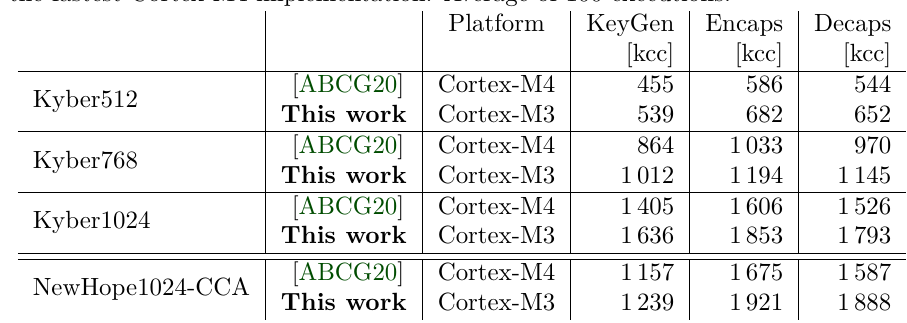
Table 6: Kyber and NewHope results on the Cortex-M3 (SAM3X8E at 16 MHz) compared to the fastest Cortex-M4 implementation. Average of 100